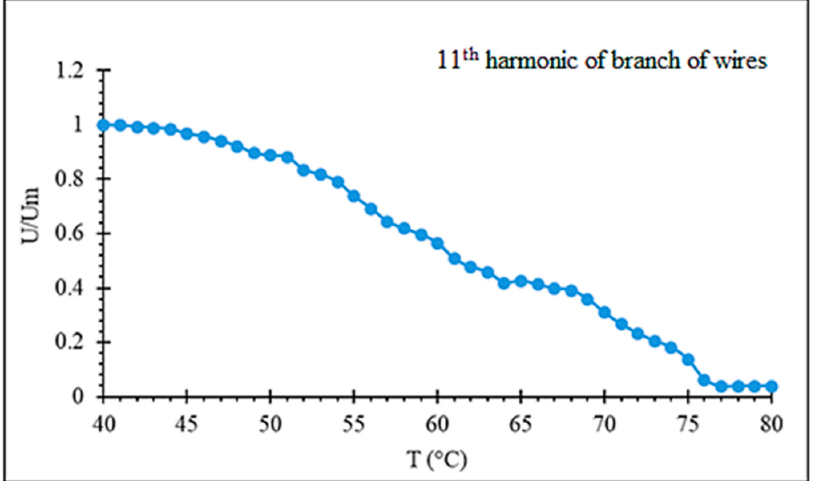
Figure 15. Effect of temperature on amplitude of 11th harmonics of a branch of five wires with different T c (1: Fe 3.9 Co 64.82 B 10.2 Si 12 Cr 9 Mo 0.08 as-cast with T C = 61.5 °C, 2: same composition, annealed at 350 °C for 5 min with T C = 55 °C; 3: same composition, annealed at 500 °C for 5 min with T C = 66 °C; 4: Fe 4.9 Co 64.82 B 10.2 Si 12 Cr 8 Mo 0.08 as cast with T C = 69 °C; and annealed at 500 °C for 25 min with T C = 78 ℃ ).